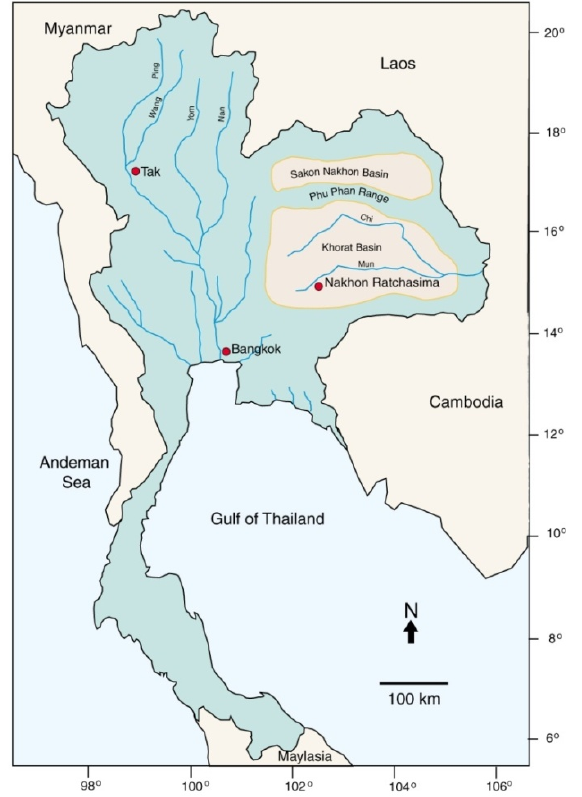
Figure 1. Thailand Map showing the main rivers in the north and northeast. Important petrified wood sites are in Tak Province and the Khorat Basin.